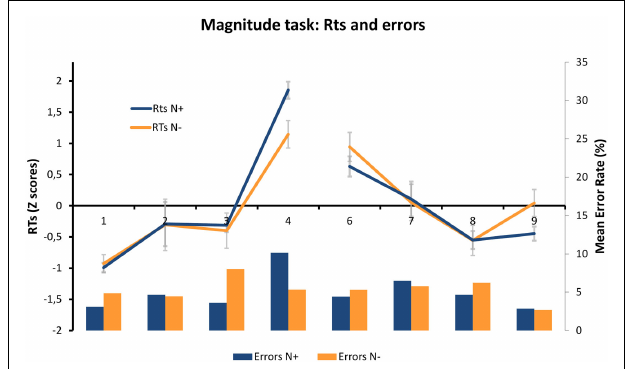
FIGURE 3 | Distance effect in the comparison task. Mean RTs (normalized to z-scores for better visualization) and error rates (percentages) are plotted as a function of numerical distance, separately for N + and N − . Error bars represent ±